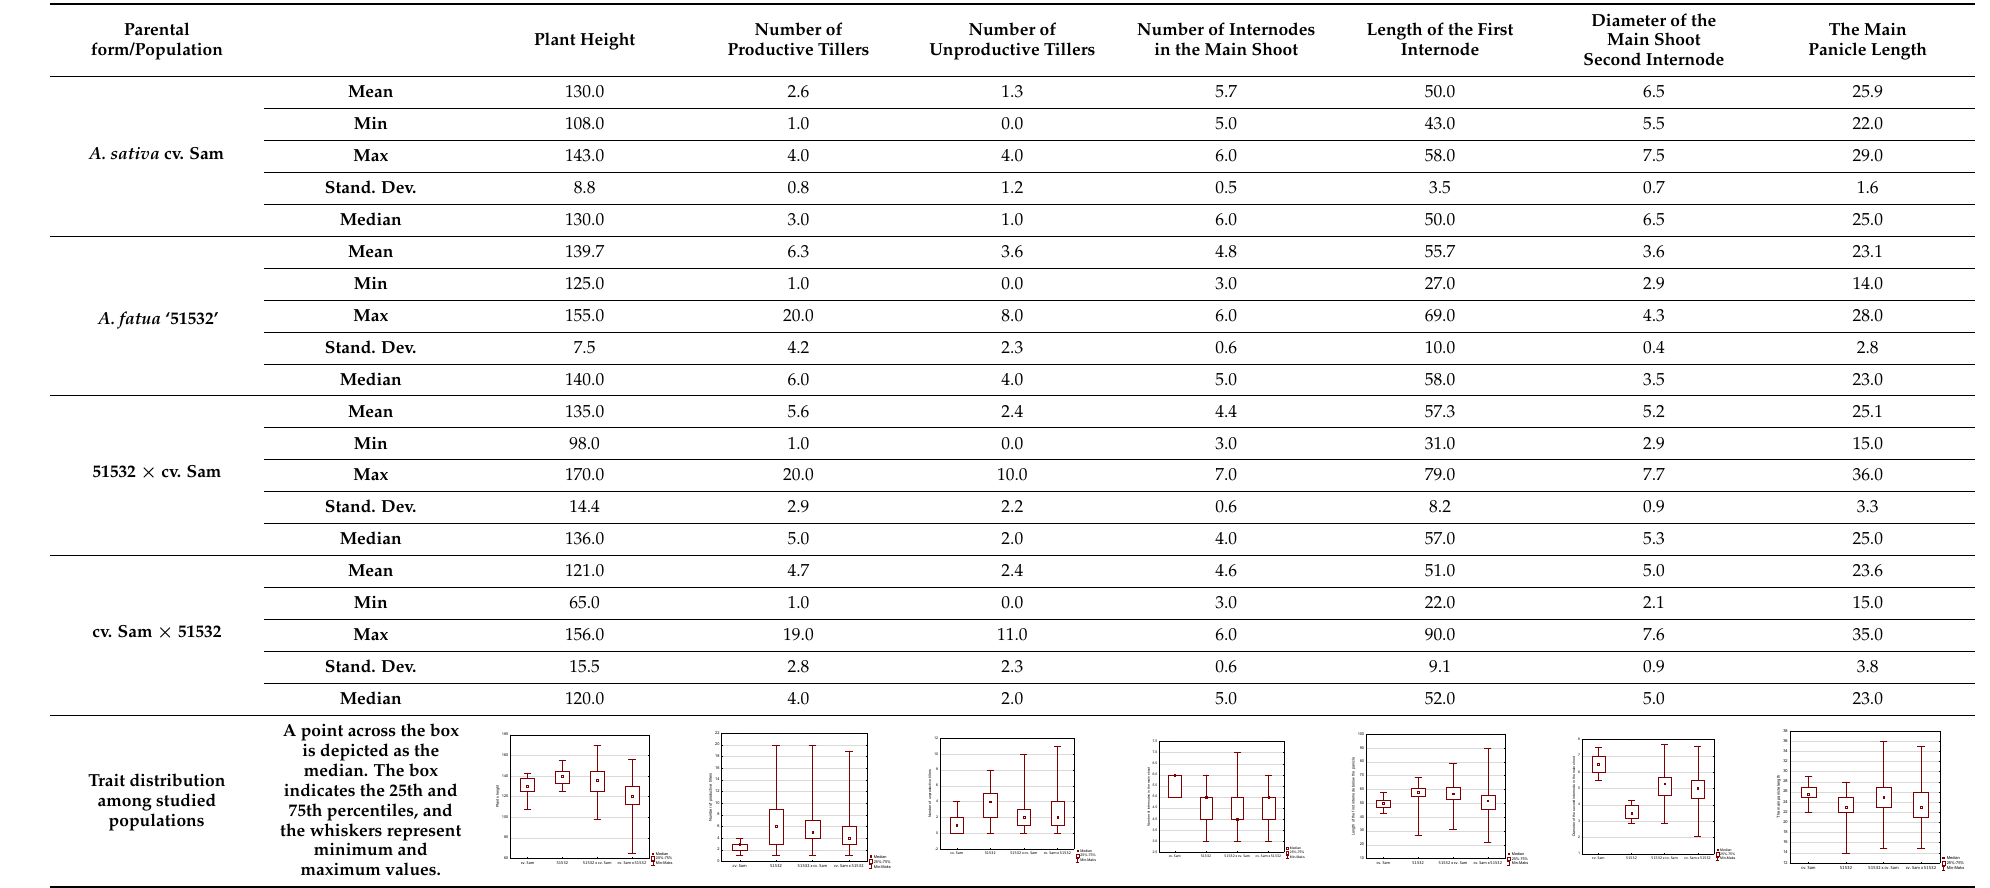
Table 1. Statistical analysis of agronomic traits of parental forms Avena sativa cv. Sam and Avena fatua ‘51532’ as well as their F 2 populations.